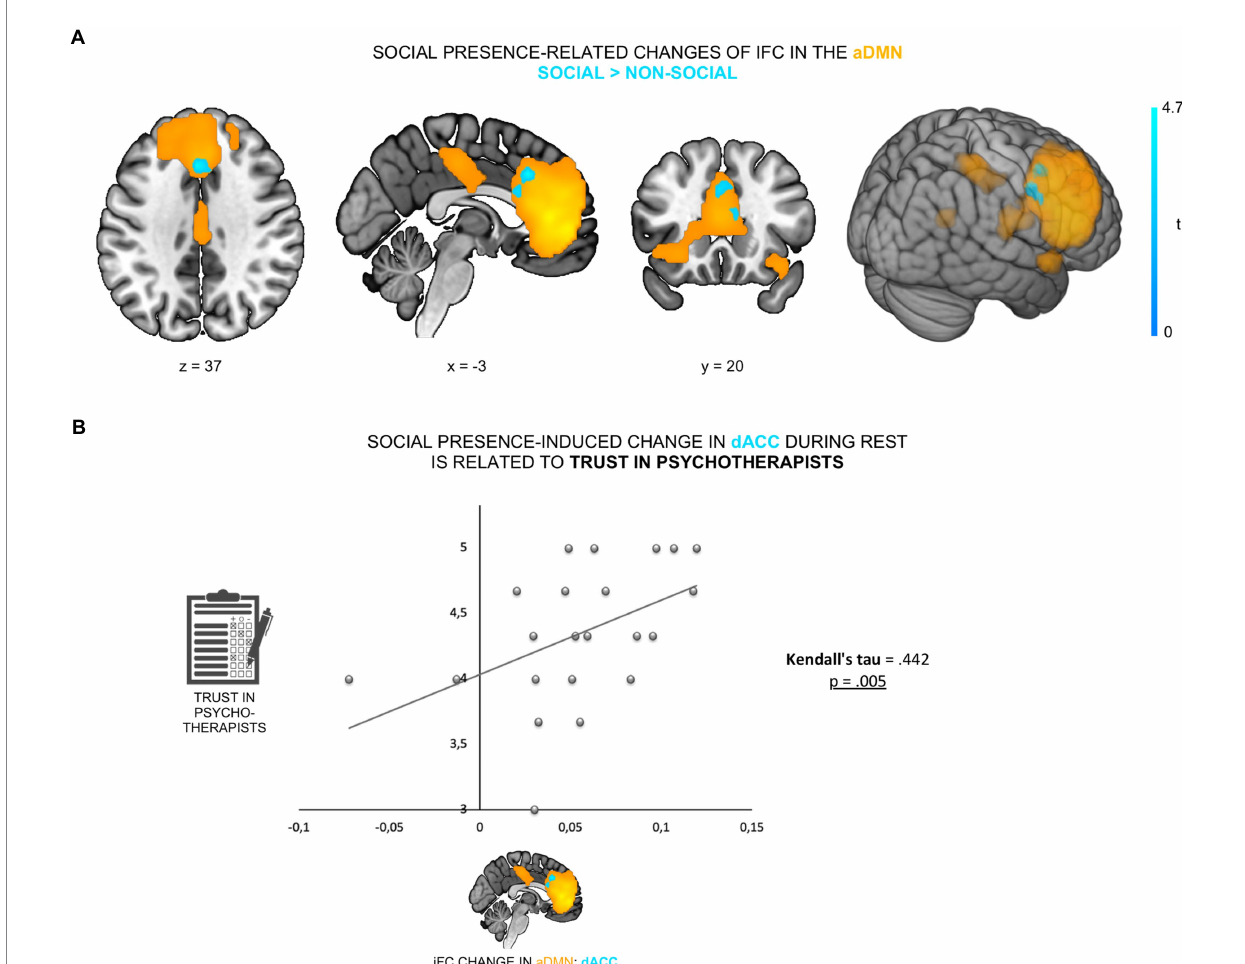
FIGURE 2 Psychotherapist’s presence enhanced iFC of dACC within the aDMN and was linked to trust in psychotherapists. (A) The contrast social > non-social exhibited an increased iFC of dACC (cyan; peak at [ − 3, 23, 37]) within the aDMN (orange). (B) This increase was positively correlated with participants’ general trust in psychotherapists (Kendall’s tau = 0.442, p =